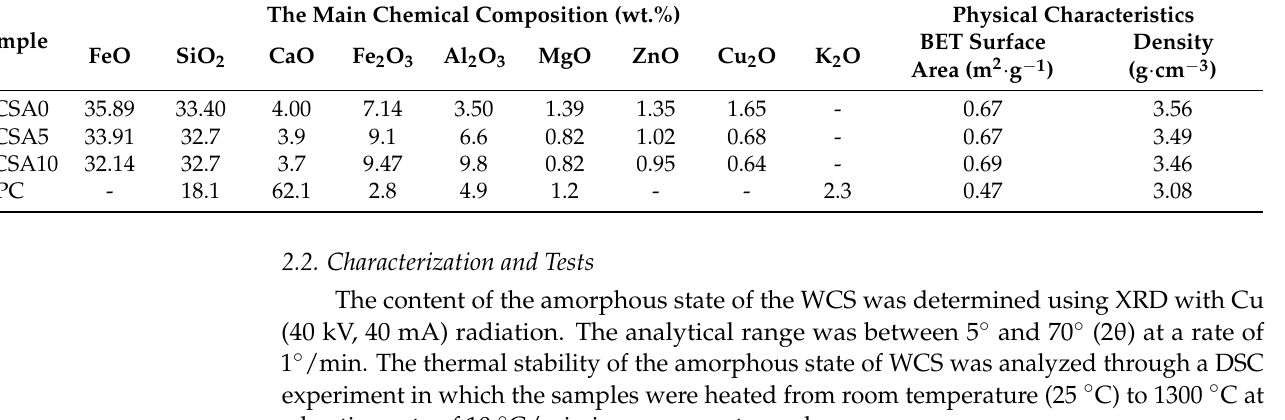
Figure 1. Hydration granulation system. Table 1. The main chemical composition (wt.%) of WCS.